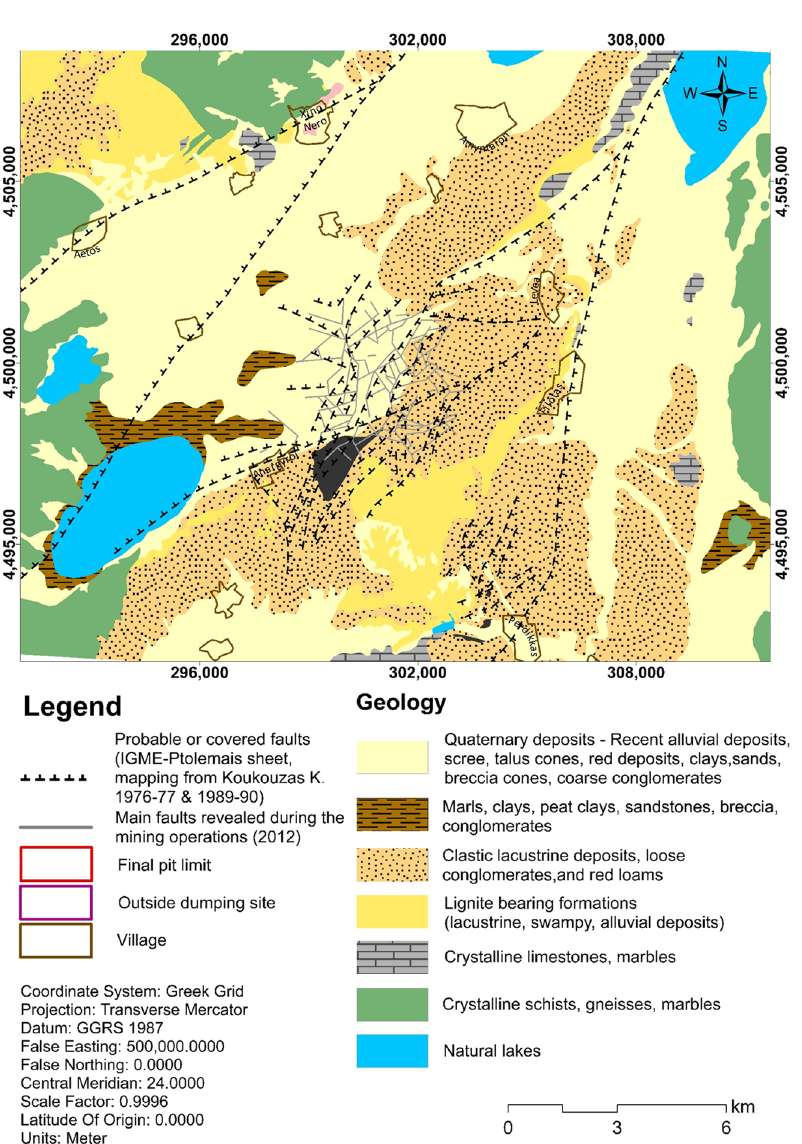
Figure 7. Simplified geological map of the Amyntaion basin which includes the mining